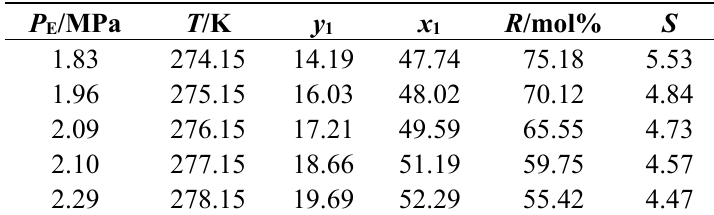
Table 3. Separation results for C 2 H 4 /CH 4 (30.08/69.92 mol%) in diesel-water emulsion with different temperatures. Initial gas-liquid volume ratio, pressure, and water cut were specified to 80, 3.4 MPa, and 30 vol%, respectively.